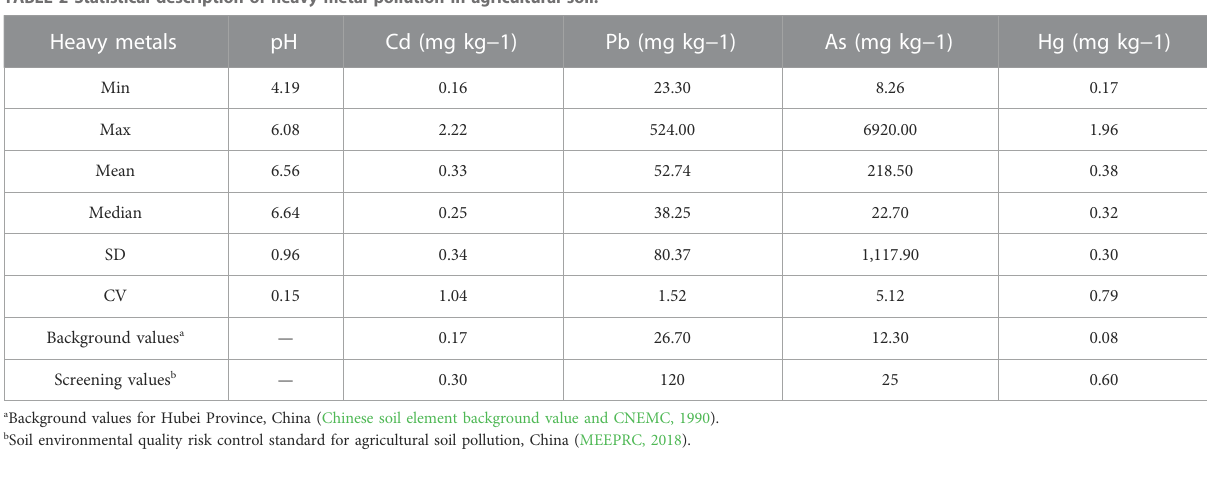
TABLE 2 Statistical description of heavy metal pollution in agricultural soil.